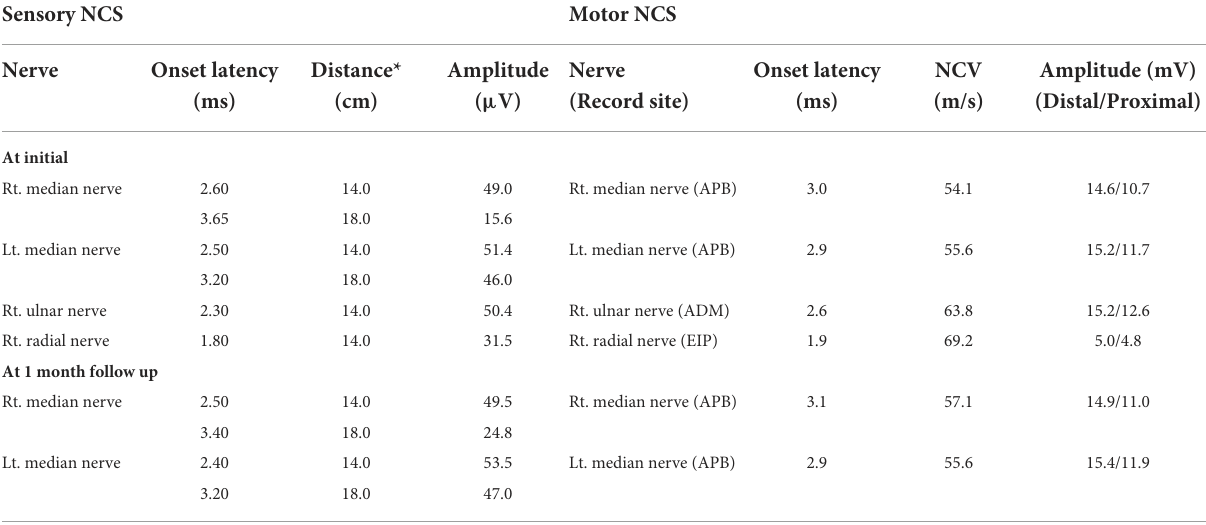
TABLE 1 Nerve conduction study of upper